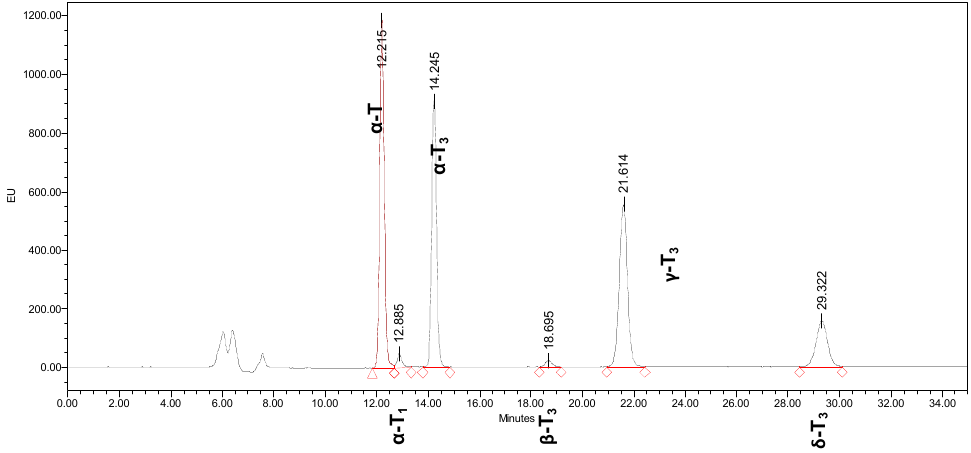
Figure 3. High performance liquid chromatography (HPLC) profile of vitamin E in palm TRF. Separation by Luna 5 µ Silica (Phenomenex, Torrance, CA, USA) with normal phase heptane:ethyl acetate (94:6 v / v ). α -T, α -tocopherol; α -T1, α -tocomonoenol; α -T3, α -tocotrienol; γ -T3, γ -tocotrienol; δ -T3, δ -tocotrienol.